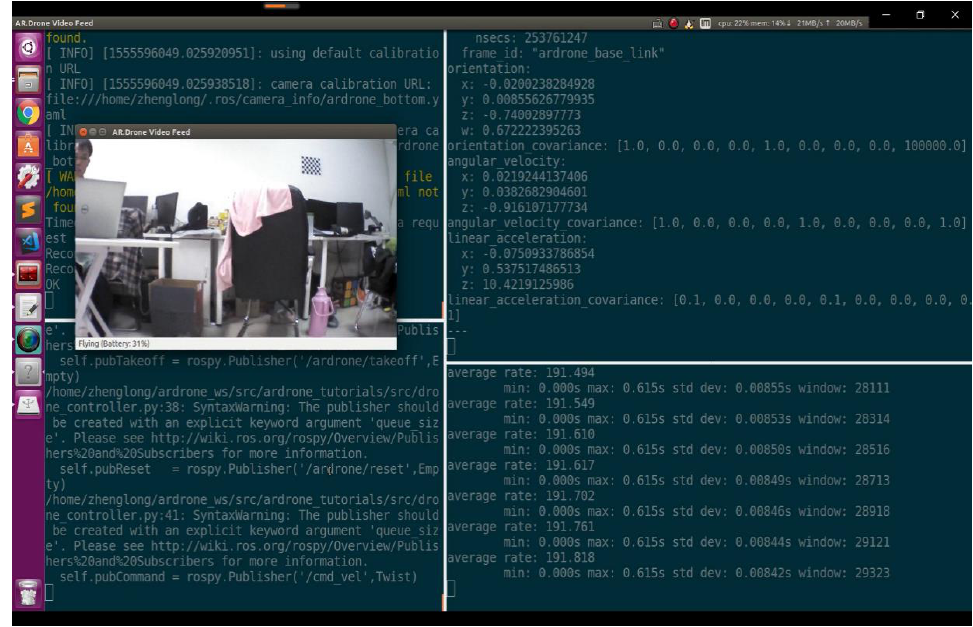
Figure 7. The monitoring screen of real-time communication between the wireless communication module on the AR.Drone platform and the laptop.